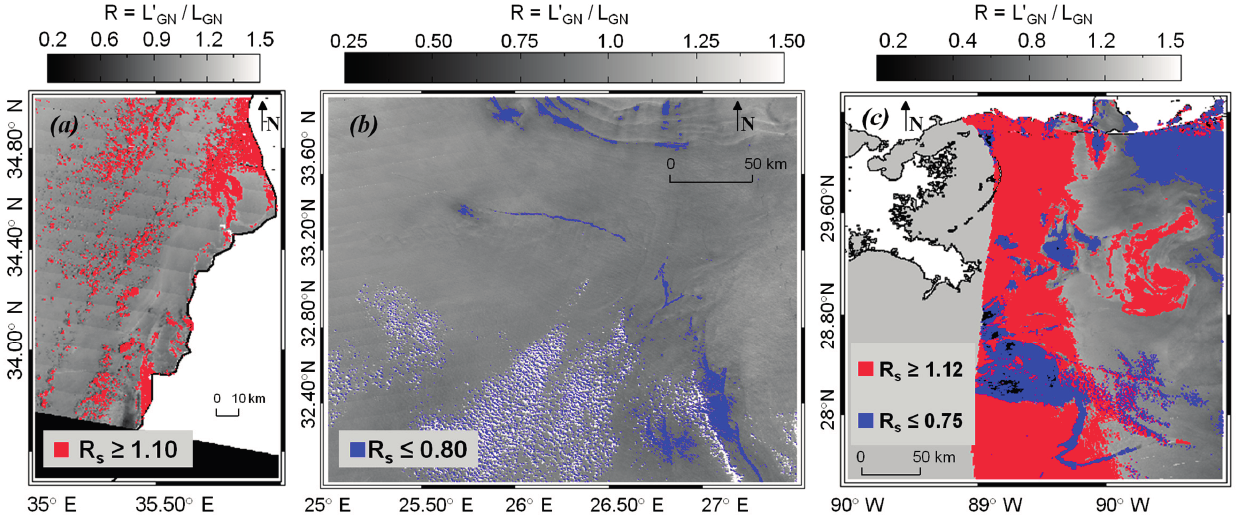
Figure 5. R for the MODIS image of: ( a ) Lebanon (Scene 2, positive contrast); ( b ) Crete (Scene 6, negative contrast); ( c ) Gulf of Mexico (Scene 7, positive and negative contrast). In red, pixels with R ≥ R s . In blue, pixels with R ≤ R s . The R s values used for detection are also